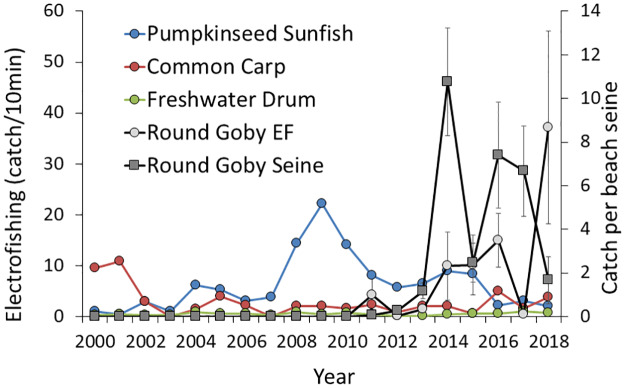
Abundance of molluscivorous fish in Onondaga Lake from 2005 to 2018.Data points represent catch per seine for beach seines and catch for 10 minutes of power-on time for electrofishing. Error bars are included for round goby (± 1 SE).